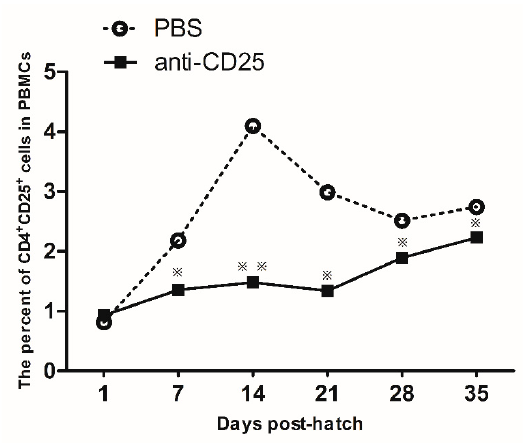
Figure 4. The percentages of CD4 + CD25 + cells in the peripheral blood post-hatch. The error bars indicate the SEM. * p ≤ 0.05, ** p ≤ 0.01.